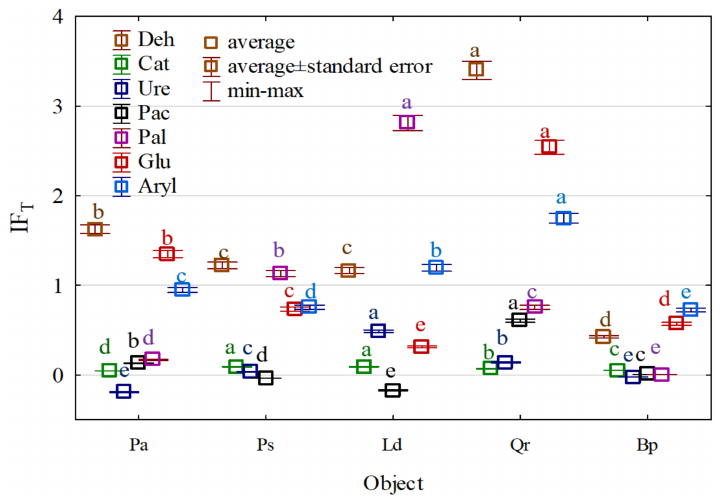
Figure 10. The index of forest stand influence on enzyme activity. Deh—dehydrogenases; Ure—urease, Pal—alkaline phosphatase, Pac—acid phosphatase, Aryl—arylsulphatase, Glu— β - glucosidase. Pa— Picea abies L., Ps— Pinus sylvestris L., Ld— Larix decidua M., Qr— Quercus robur L., and Bp— Betula pendula L. Homogeneous groups (denoted with letters a–e) were calculated separately for each